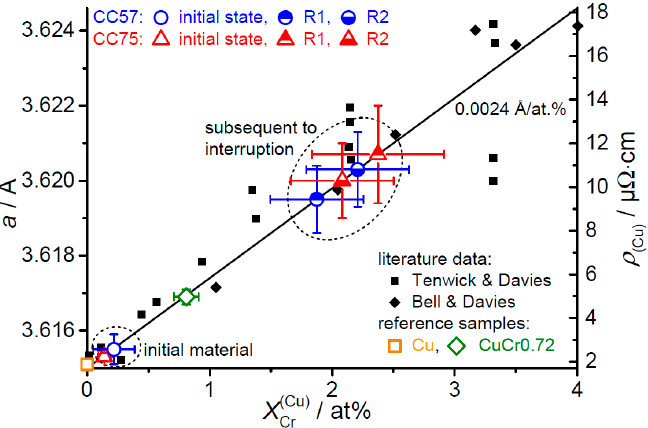
Ω · cm ( ρ = 1.71 + 4.12 µ Ω ·cm × X Cr(Cu) × X ( Cu ) [25]) (Cu) (Cu) at % Cr at %